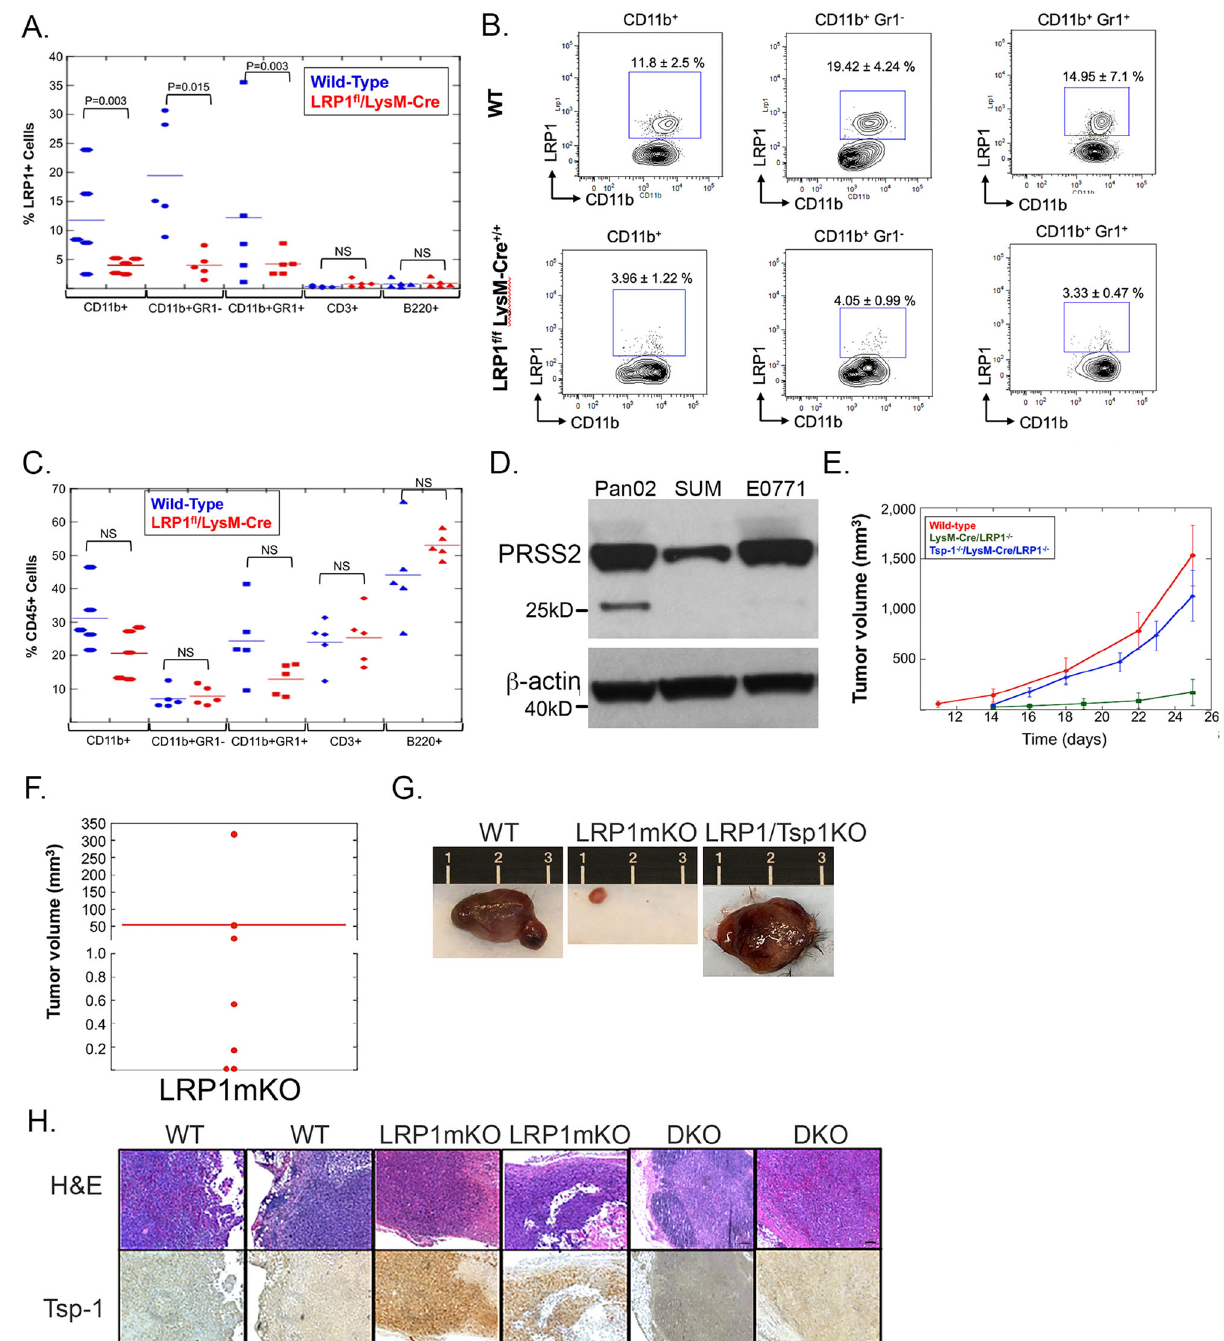
Fig. 6 | Myeloid-speci fi c deletion of LRP1 inhibits tumor growth by preventing the repression of Tsp-1. A Plot of percentage of LRP1+ multiple myeloid and lymphoid cellsin wild-type( n =5)and LysM-Cre/LRP1 fl / fl ( n =5) miceasdetermined by FACS analysis. B Representative FACS plots of LRP1 expression in myeloid and lymphoid cells in wild-type and LysM-Cre/LRP1 fl / fl mice ( n =5 per group). C Plot of relative abundance of CD45+ myeloid and lymphoid cells in wild-type ( n =5) and LysM-Cre/LRP1 fl / fl ( n =5) mice as determined by FACS analysis. D Western blot of PRSS2 and Actin in Pan02 murine pancreatic cancer cells, SUM159 human breast cancer cells, and E0771 murine breast cancer cells ( n =3). E Plot of average tumor